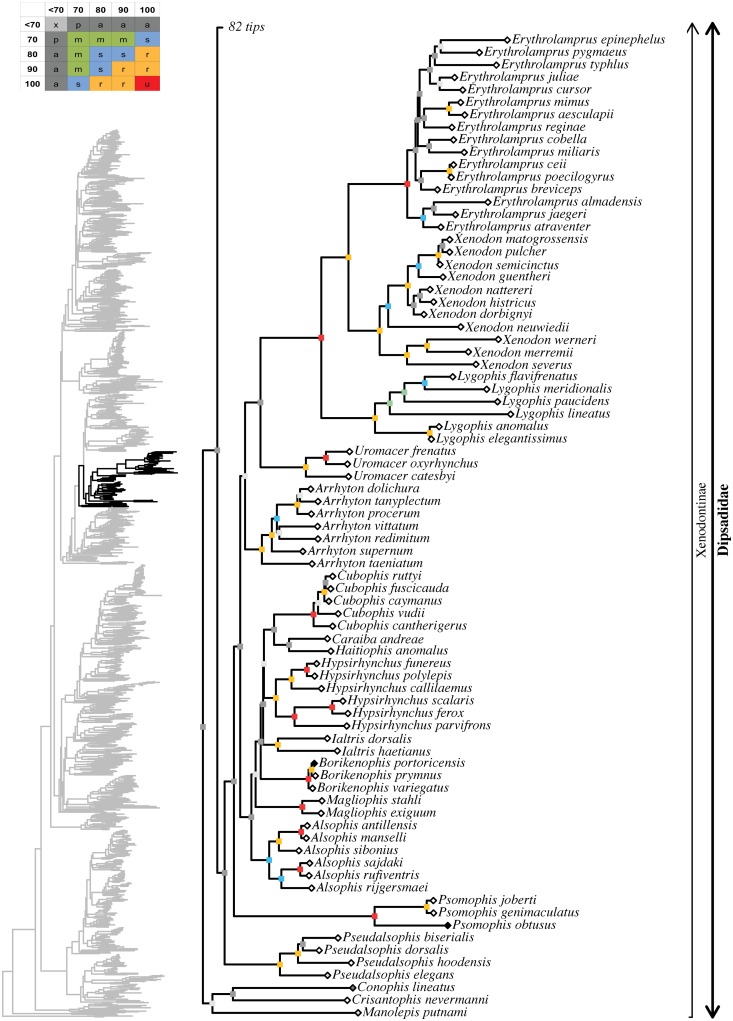
Maximum likelihood species-level phylogeny of Colubroides
(continued).Family Dipsadidae (continued).